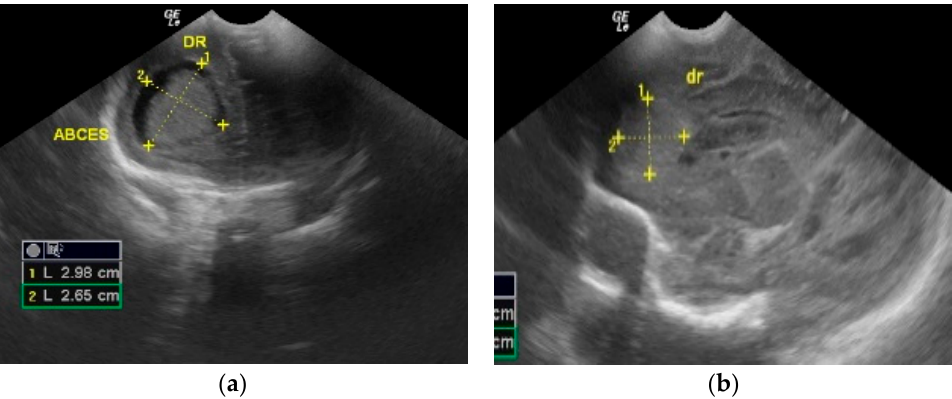
Figure 2. Brain ultrasound on the 7th day of life performed in 2 sections: ( a ) Frontal coronal plan, ( b ) right parasagittal plan) that showed a nodular frontal lobe lesion without a proper wall identifiable by ultrasound and with heterogeneous, suggestive necrotic content.